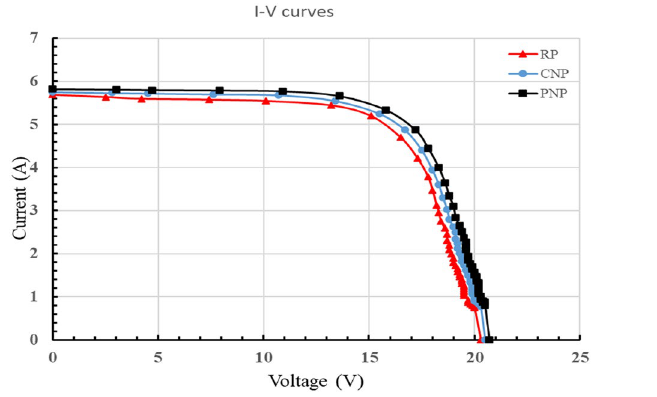
Figure 11. The I–V curve for RP, CNP, and